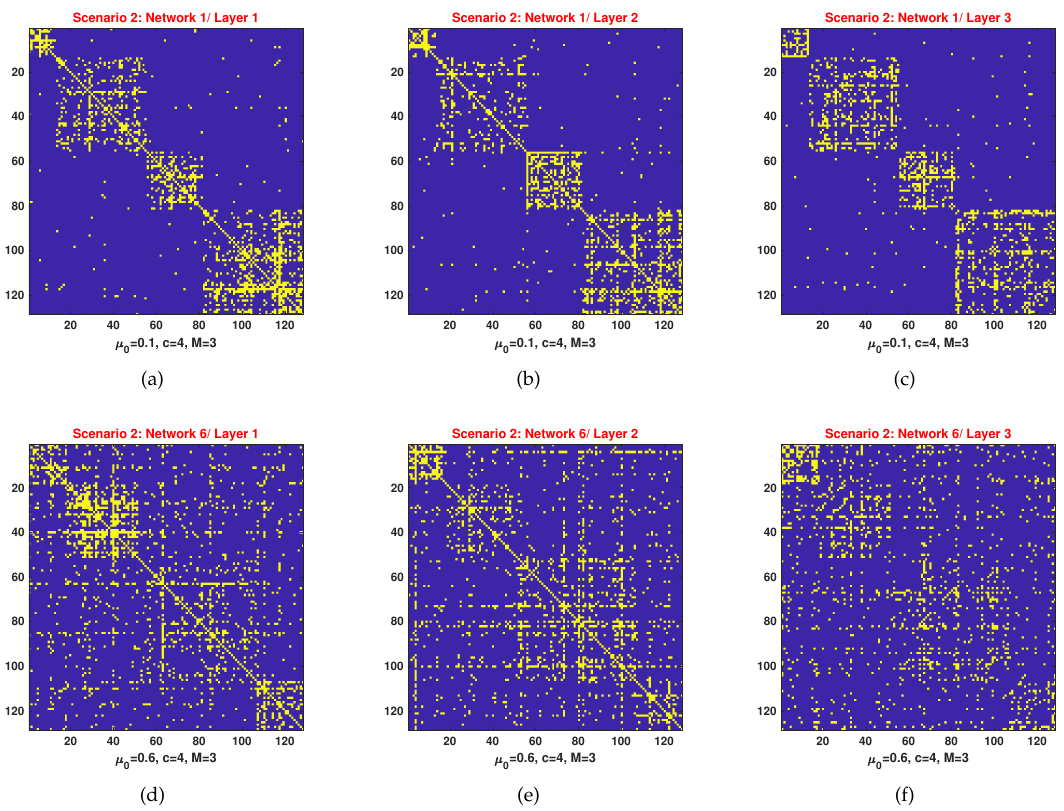
Figure 3. Examples showing some of the simulated 3-layer multiplex networks generated with n = 128, c = 4 and variable µ 0 . ( a – c ) Adjacency matrices with µ 0 = 0.1; ( d – f ) Adjacency matrices with µ 0 = 0.6.